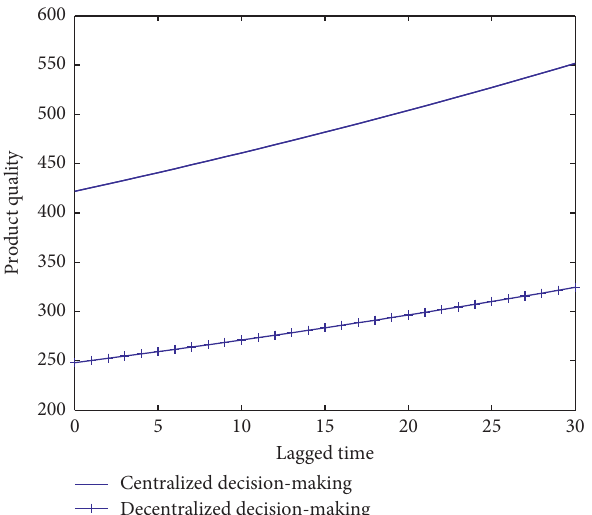
Figure 2: Contrast of the manufacturer’s product quality level under the two decision-making modes.